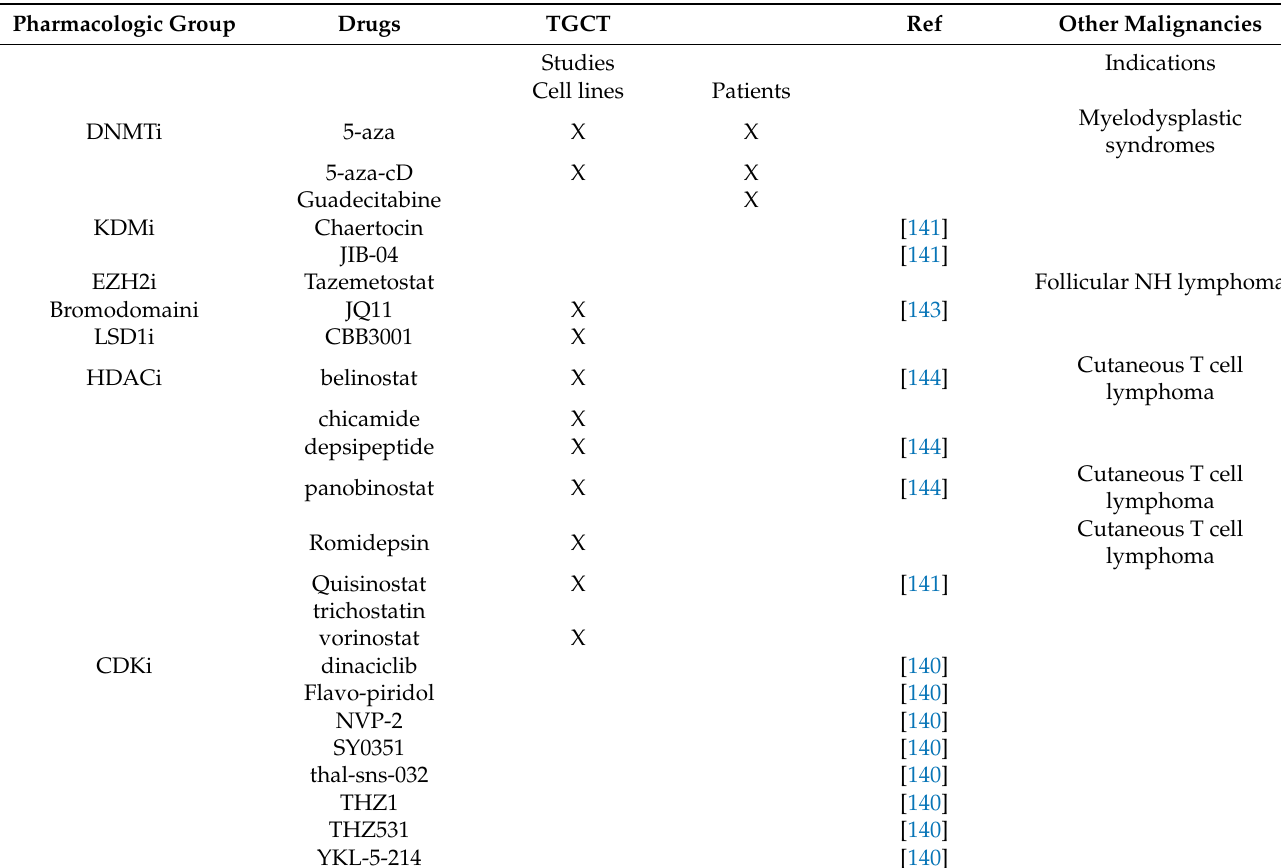
Table 2. Epidrugs in TGCT and other